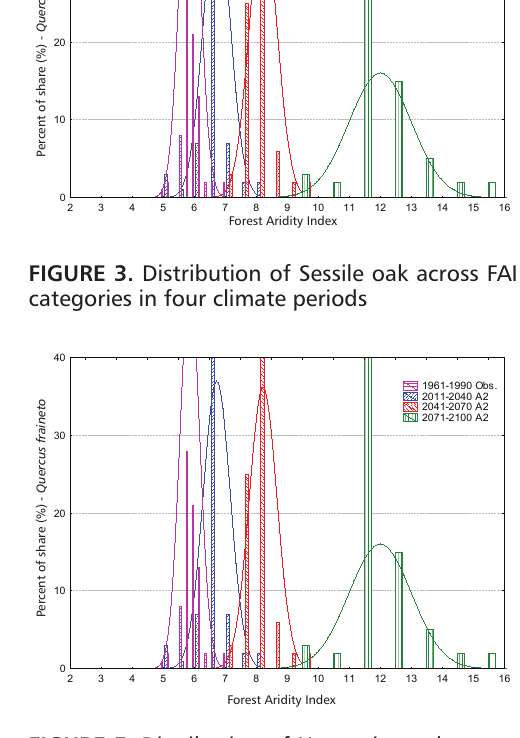
FIGURE 4. Distribution of Turkey oak across FAI categories in four climate periods